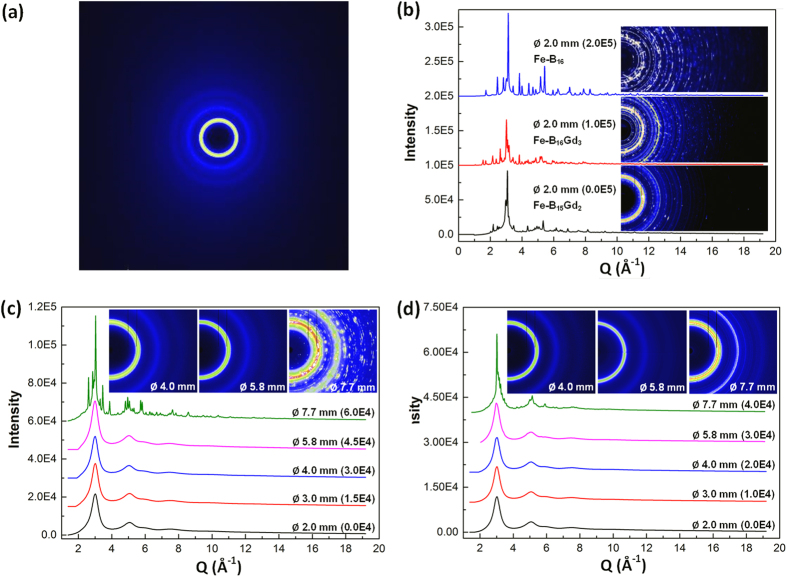
The selected 2D SXRD patterns acquired from the 2.5 ± 0.1 mm thick disk-shaped samples cut off from the different diameter sections of the as-cast step bars, and the corresponding integrated 1D profiles.(a) The 2D diffraction pattern acquired from the Fe-B6Gd2 alloy, (b) the Ø2 mm sections from the Fe-B16, Fe-B16Gd3, and Fe-B15Gd2 alloys, (c) different diameter sections from Fe-B6Gd2 alloy, and (d) different diameter sections from Fe-B6Y2 alloy.